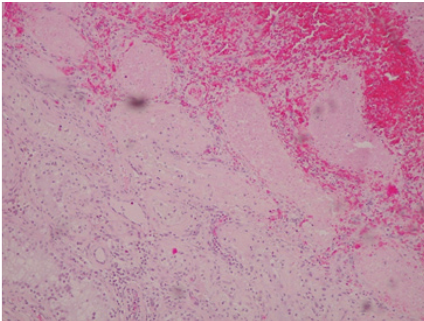
Figure 3: Histological section (H&E stain) of the left testicle viewed at medium power demonstrating hemorrhagic infarction of seminiferous tubules secondary to underlying